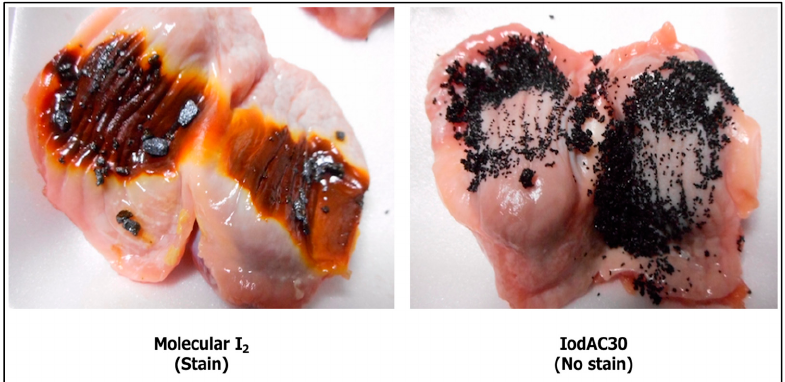
Figure 5. Staining test on chicken gizzards, after direct contact for 8 h. C 2021 , 7 , x FOR PEER REVIEW